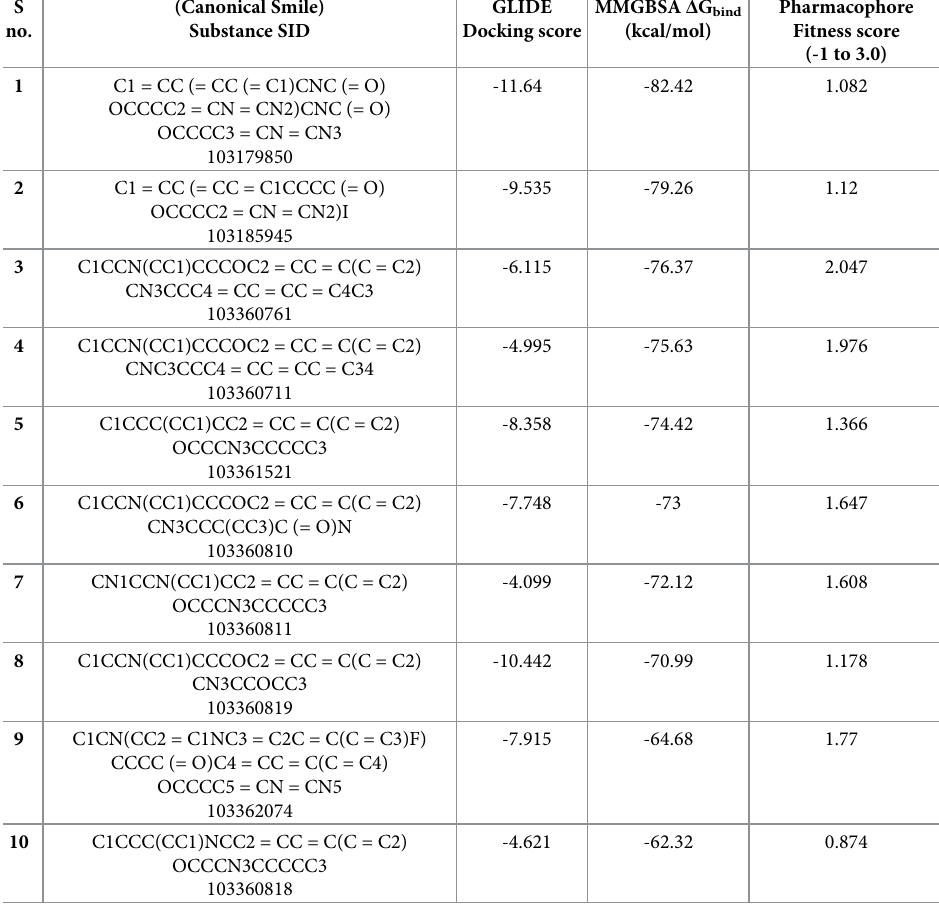
Table 3. Binding profile with HDAC2 and dual inhibitory fitness of lead molecules. S